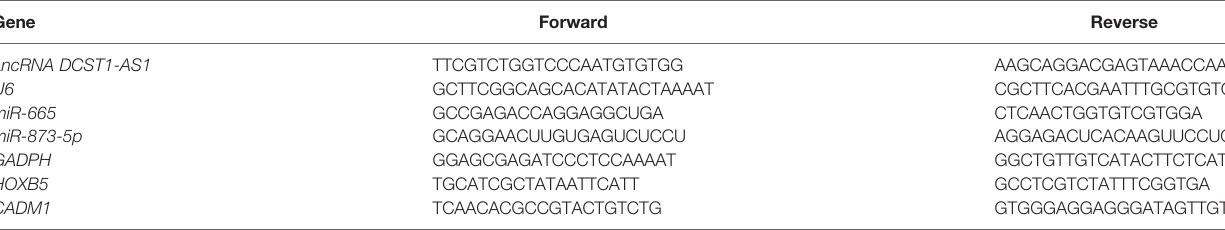
TABLE 1 | The primers sequence for qRT-PCR